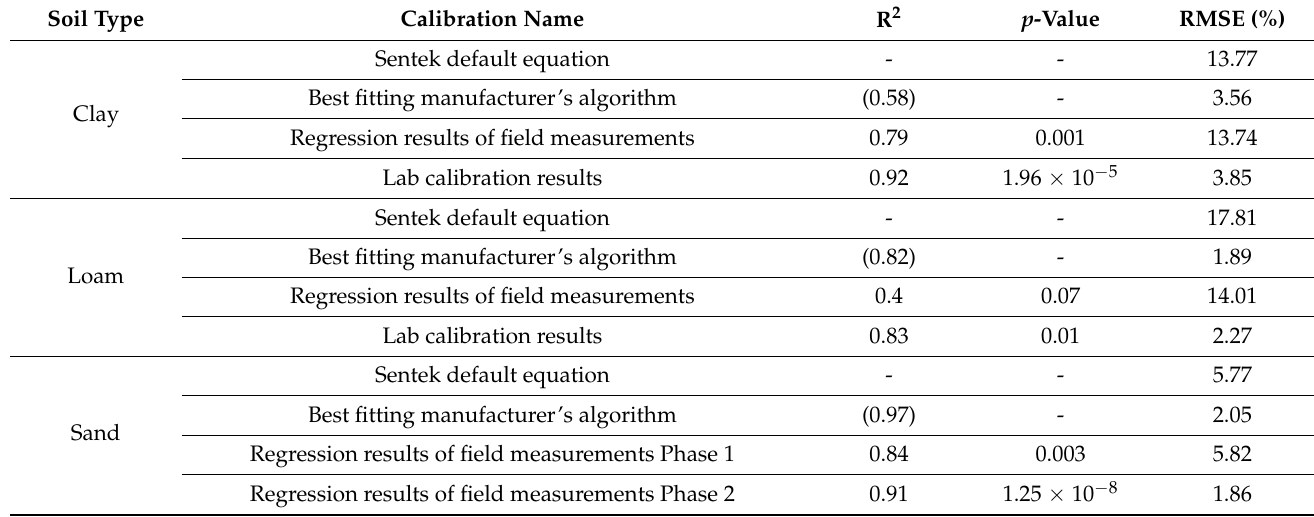
Table 11. Summary of statistical metrics associated with coefficients of both field and laboratory calibration equations. Soil